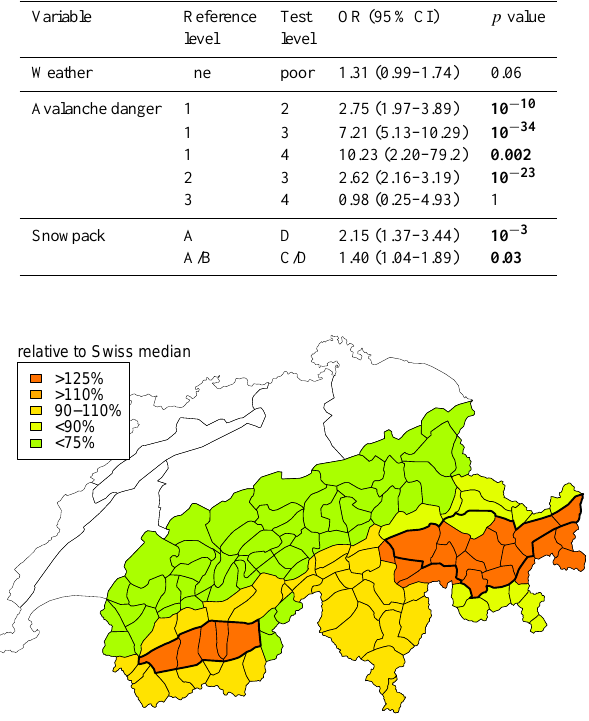
Figure 4. The map shows the ratio of accidents to activity for each region, relative to the Swiss median. The ratio was highest in re- gions VS2, GR2 and GR3, which are almost identical with the re- gions defined as the inner-alpine regions (bold black lines; SLF, 2014) in the avalanche